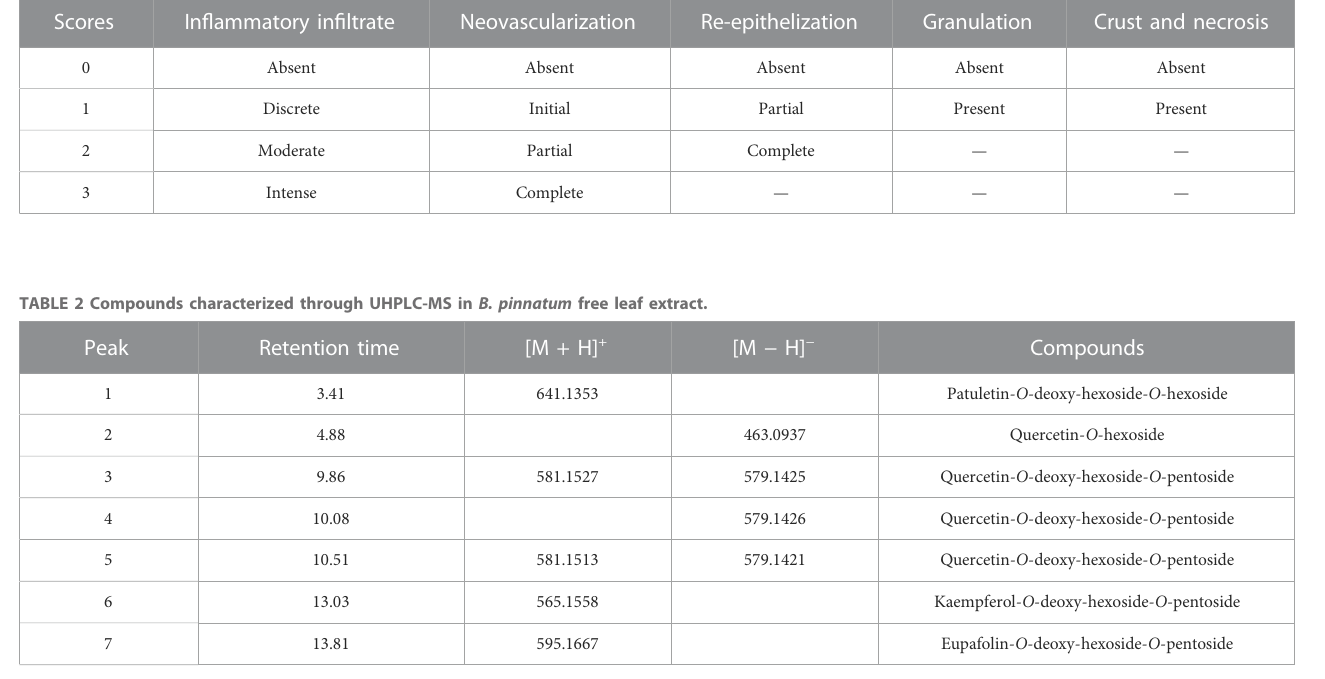
TABLE 1 Criteria for histological analysis of healing. Scores